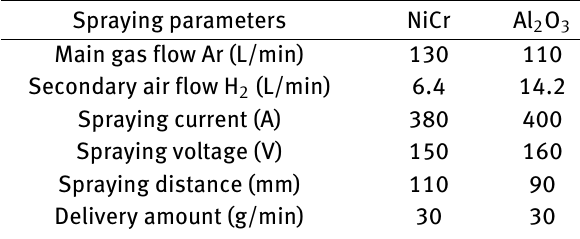
Table 1: Spraying parameters Spraying